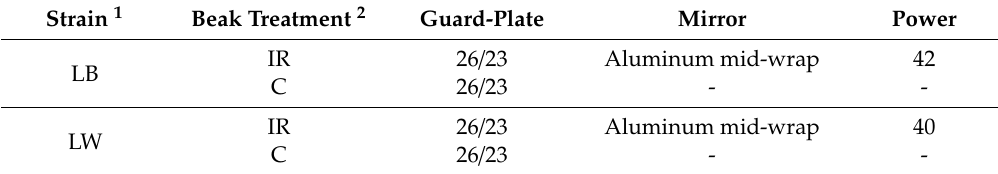
Table 1. Infrared beak treatment settings applied to Lohmann Brown-Lite and Lohmann LSL-Lite chicks. Strain 1 Beak Treatment 2 Guard-Plate Mirror Power IR 26 / 23 Aluminum mid-wrap LB 26 /